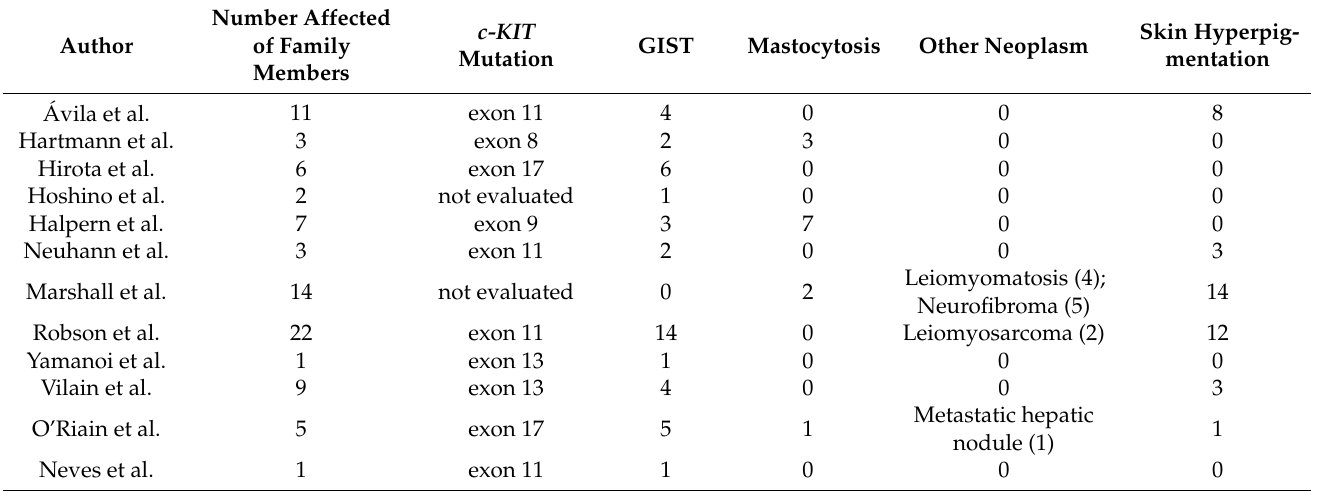
Table 1. Germline c-KIT mutation associated with achalasia-like symptoms and neoplasms development. Main